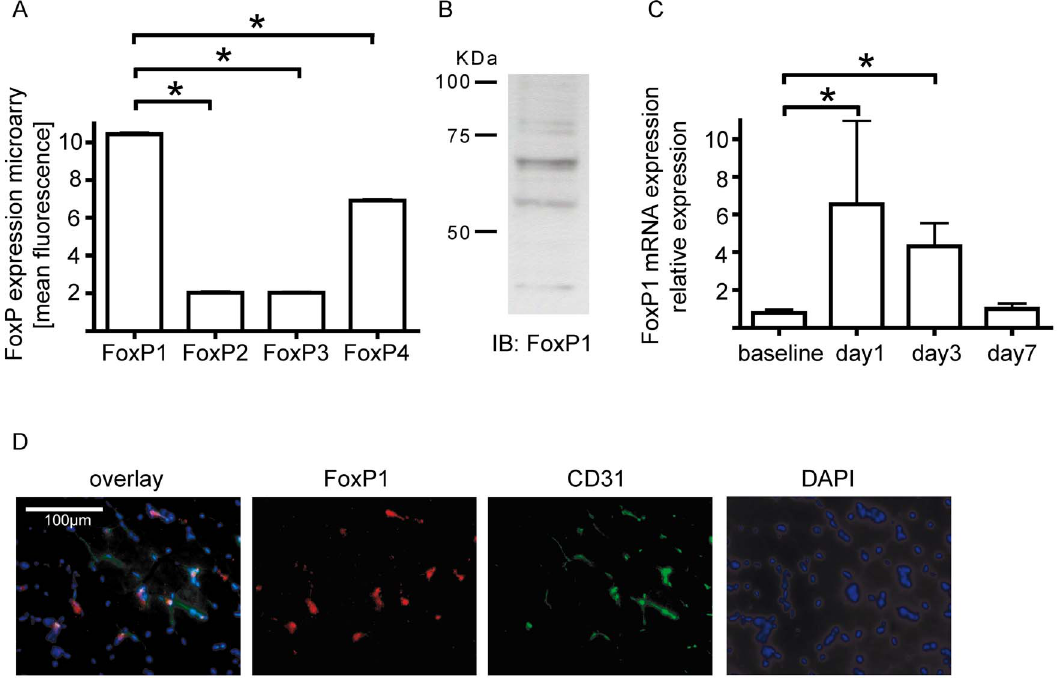
Figure 1. Foxp1 is highly expressed in endothelial cells and upregulated during blood vessel growth in vivo. Microarray analysis of Forkhead box P transcription factor expression in human umbilical vein endothelial cells showed the highest expression for the FoxP1 subtype (A), with the highest expression of the 68kDa splice variant on protein level (B). (*=p , 0.05) In vivo, FoxP1 expression is upregulated at the site of neovascularization upon induction of hindlimb ischemia in mice (C). Immunofluorescent double staining of FoxP1 (red) with the endothelial marker CD31 (green) and a nuclear staining (DAPI, blue) localized FoxP1 expression to endothelial cells of the capillary vasculature in the gastrocnemius muscle of the mouse hindlimb (D).